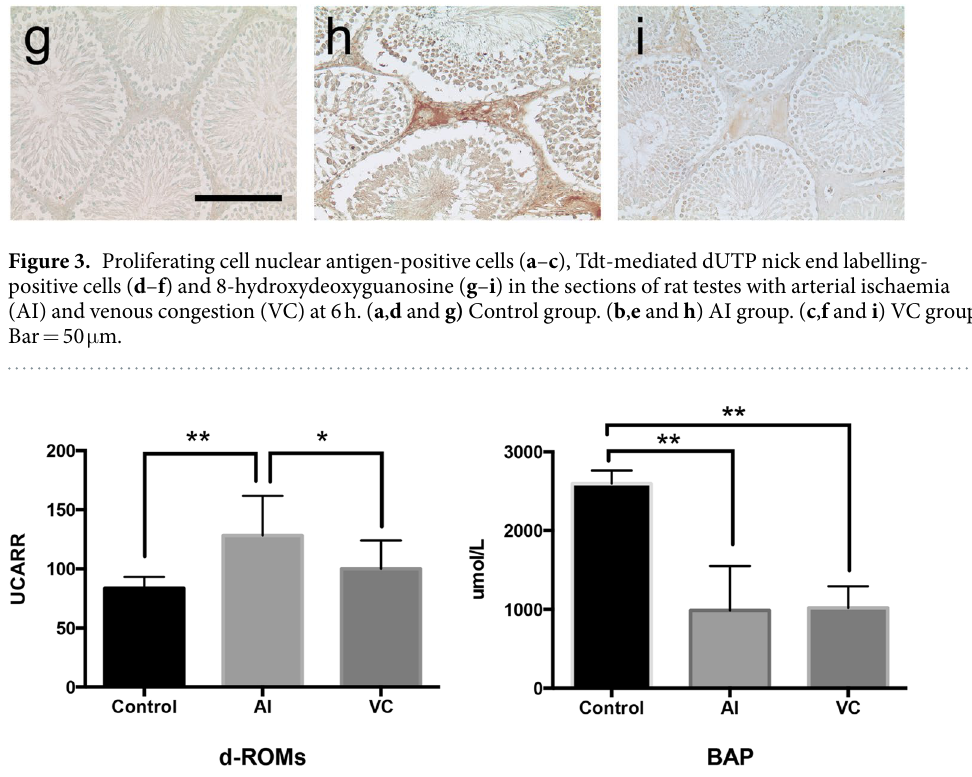
Figure 4. Reactive oxygen metabolite-derived compound (ROM) test and the biological antioxidant potential (BAP) test in rat testes with arterial ischaemia (AI) and venous congestion (VC) at 6 h. Data are expressed as means ± SD, and the two-way analyses of variance and Tukey–Kramer tests were used for statistical analyses. P > 0.05 was considered as indicating nonsignificant differences. * P < 0.05. ** P <